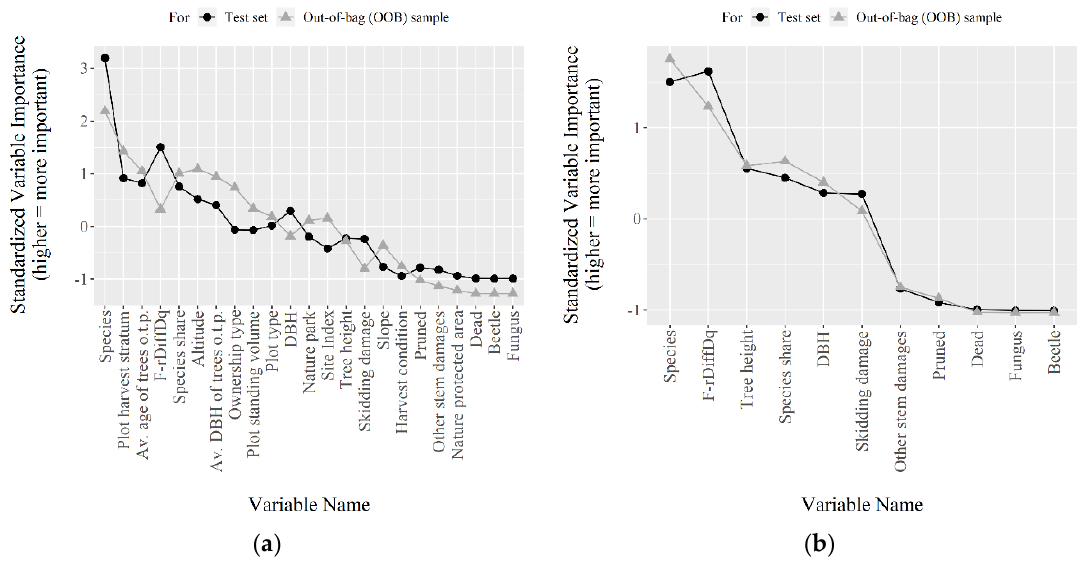
Figure 3. Standardized variable importance (VI) as permutation importance for CTree-RF in ( a ) the variation that used plot- and tree-level attributes as well as strata and ( b ) the variation that used tree-level attributes and strata only (DBH: Diameter at breast height, Av.: average, o.t.p.: on the plot).